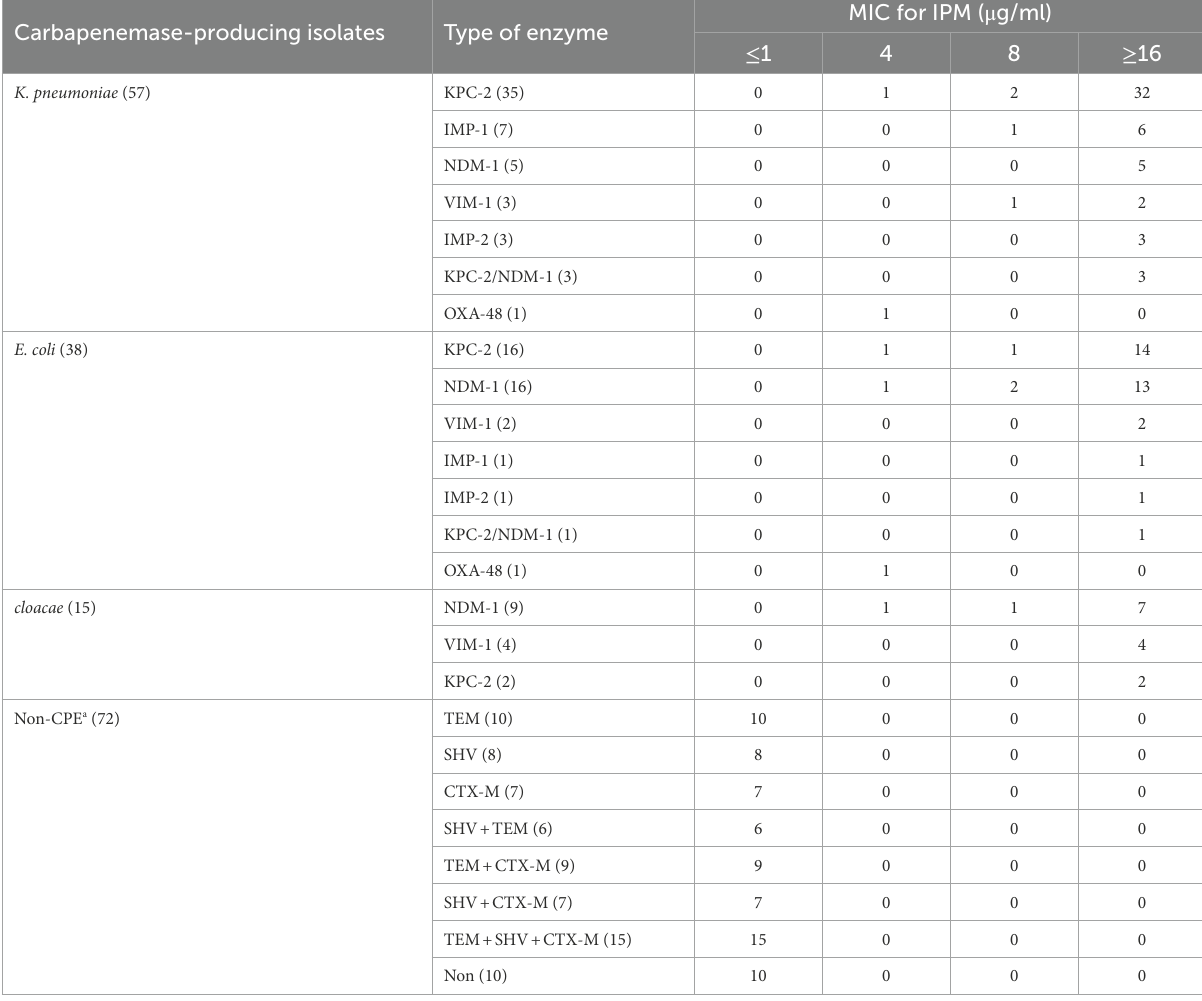
TABLE 1 Number of isolates found to produce various carbapenemases and the MICs of IPM for